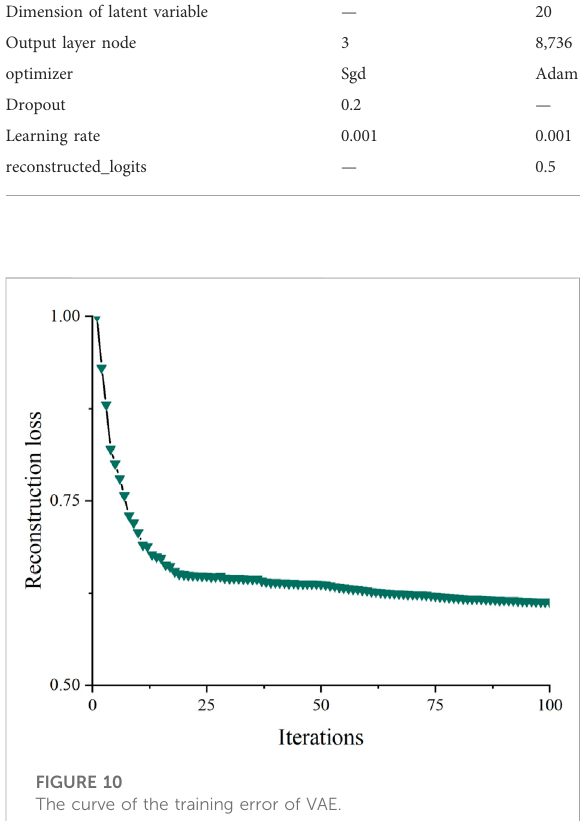
FIGURE 10 The curve of the training error of VAE.